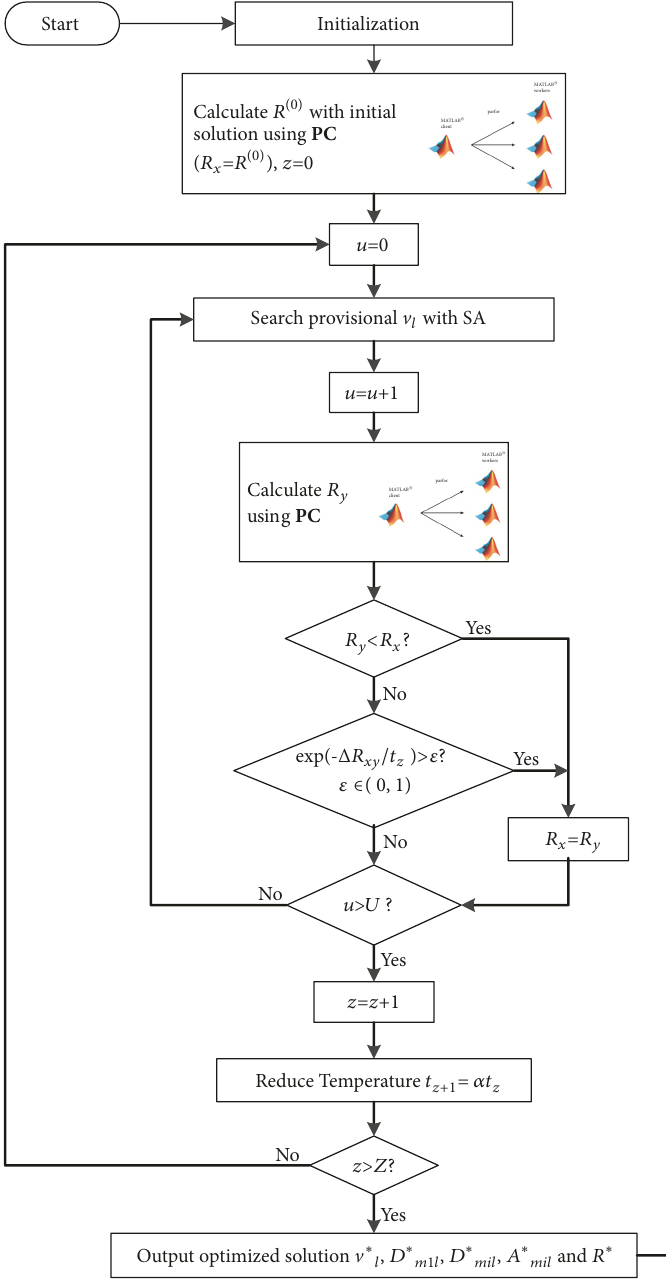
Figure 3: Step procedure of the proposed